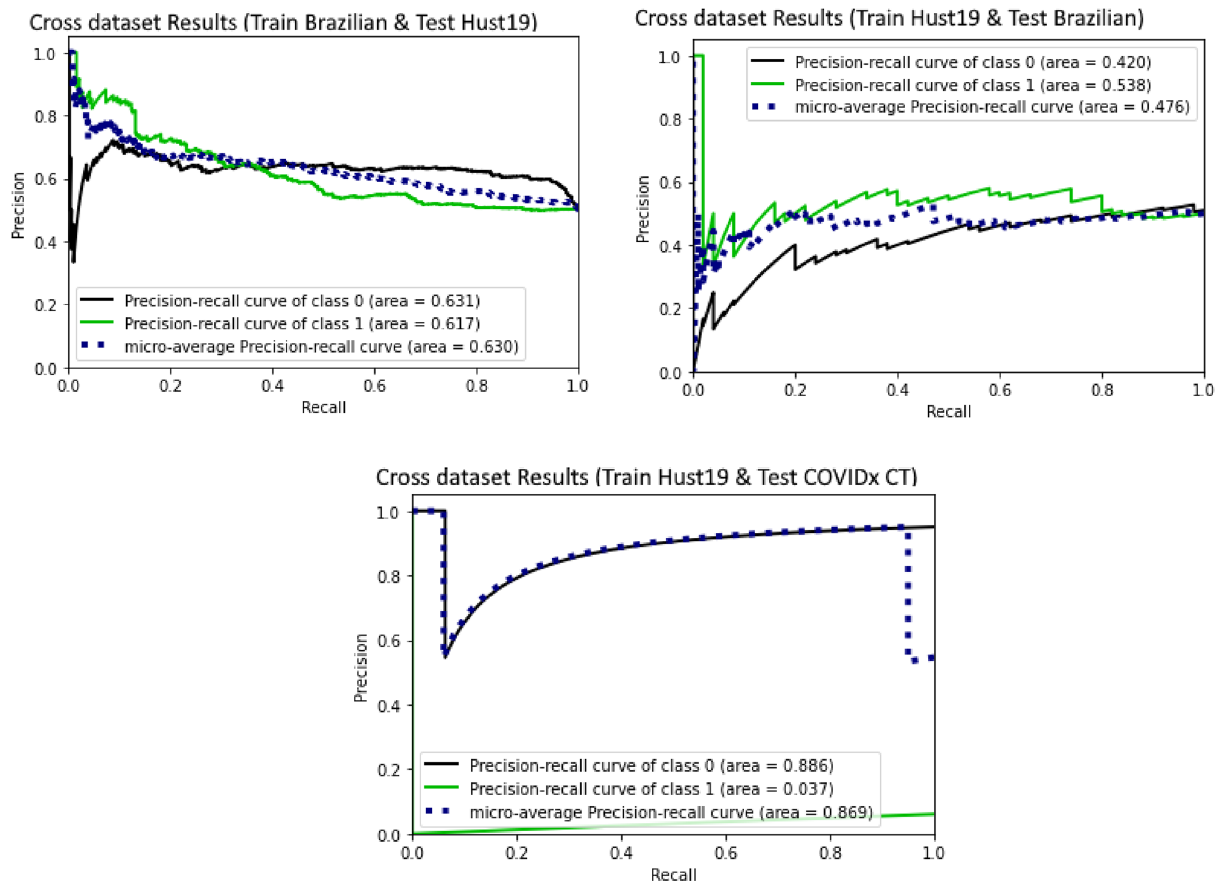
Figure 10. ( a ) Cross dataset Results (Train Brazilian & Test Hust19) ( b ) Cross dataset Results (Train Hust19 & Test Brazilian) ( c ) Cross dataset Results (Train Hust19 & Test COVIDx CT).